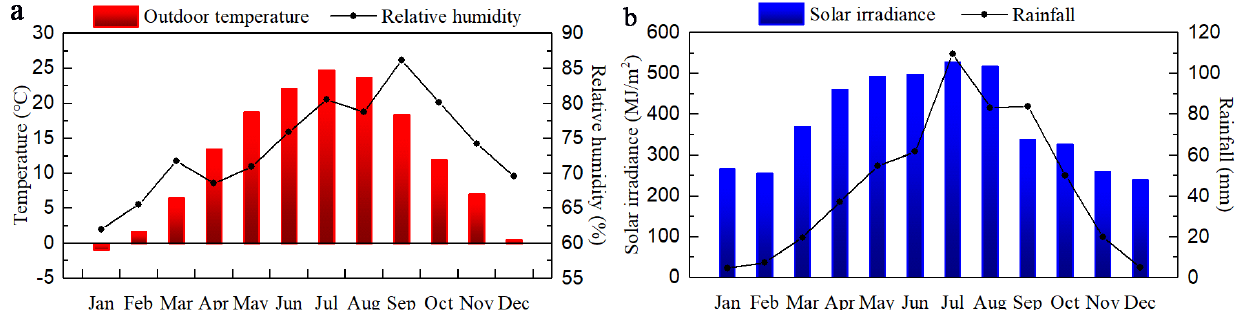
Figure 3. Climate data of Sanmenxia city: ( a ) annual temperature and humidity; ( b ) annual solar irradiance and rainfall.